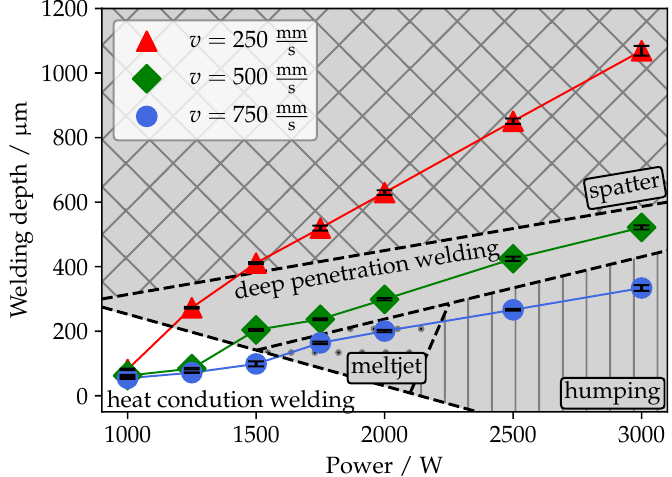
Figure 3. Mean welding depth ( n = 6) of welding copper with a green laser and a focal diameter of 300µm; white: heat conduction welding, grey: deep penetration welding, cross pattern: increased spatter formation with spatter sizes > 100 µ m, dotted area: jet effect of the molten material, vertical lines: